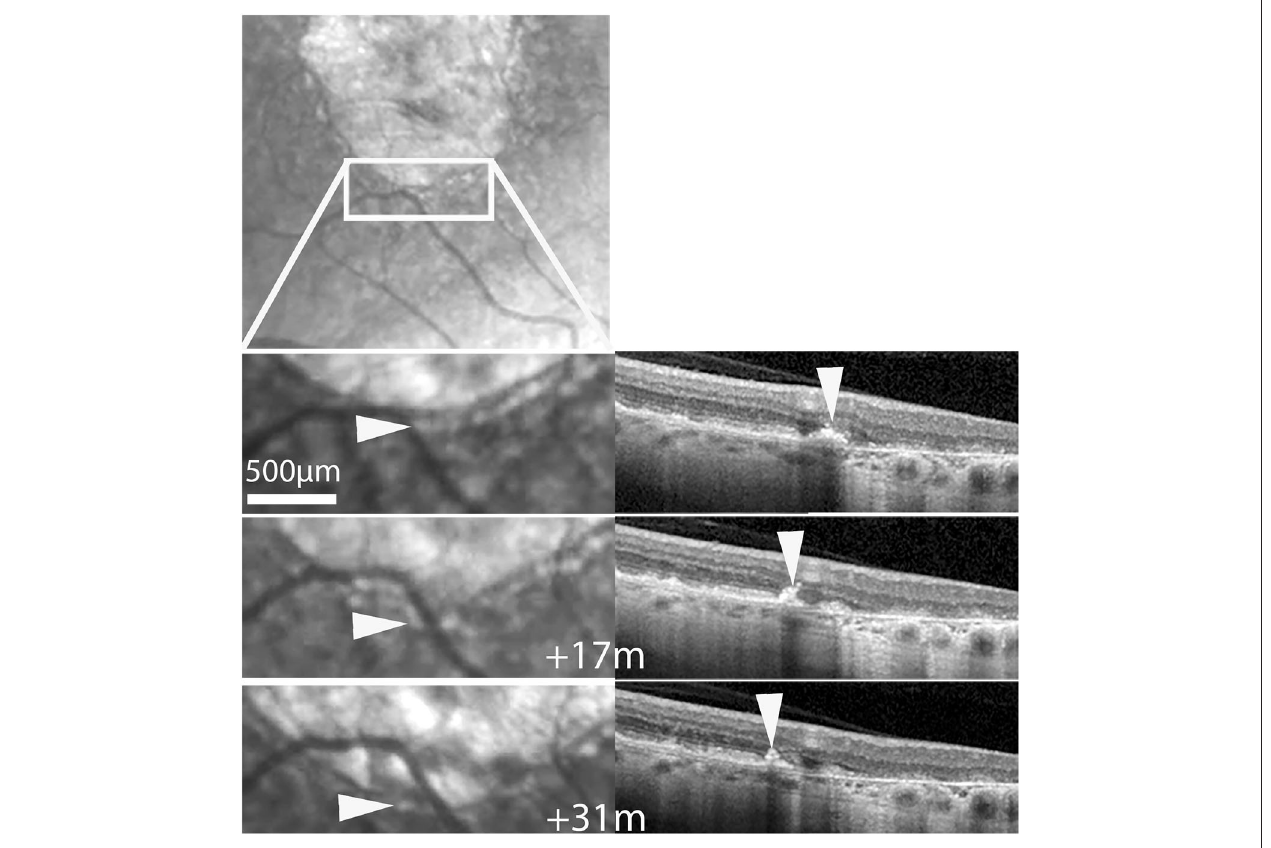
FIGURE 5 | Case 2. Follow-up by SLO and OCT of a subretinalhyperreflective spot. Top, SLO IR image showing the area displayed below. Bottom shows magnifications at three time-points. Arrowheads follow a hyperreflective spot seen by SLO IR (left column) and OCT (See also Supplementary Video 5